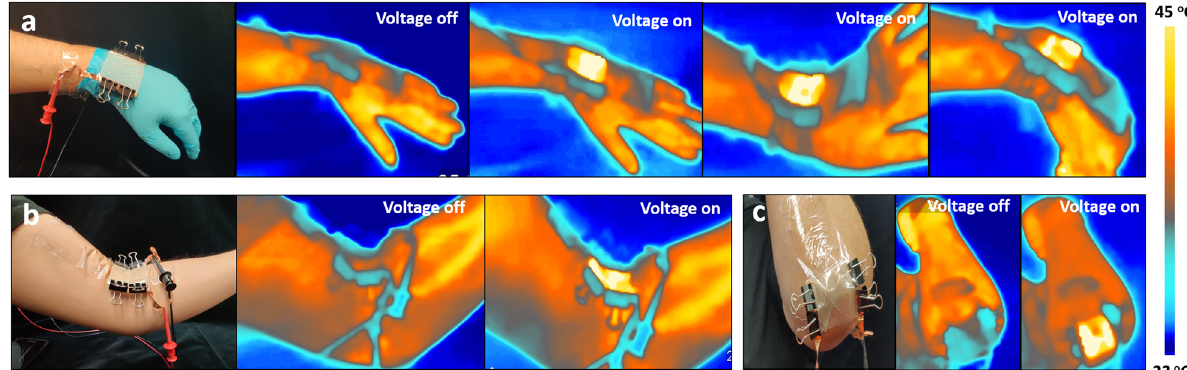
Fig. 4 Digital and infrared photographs of the thermotherapy patch in use. a Temperature distribution image of bioinspired thermotherapy patch af fi xed to the human wrist in normal, inward, and outward bending conditions. b , c The patch af fi xed to the cubital fossa area and elbow,